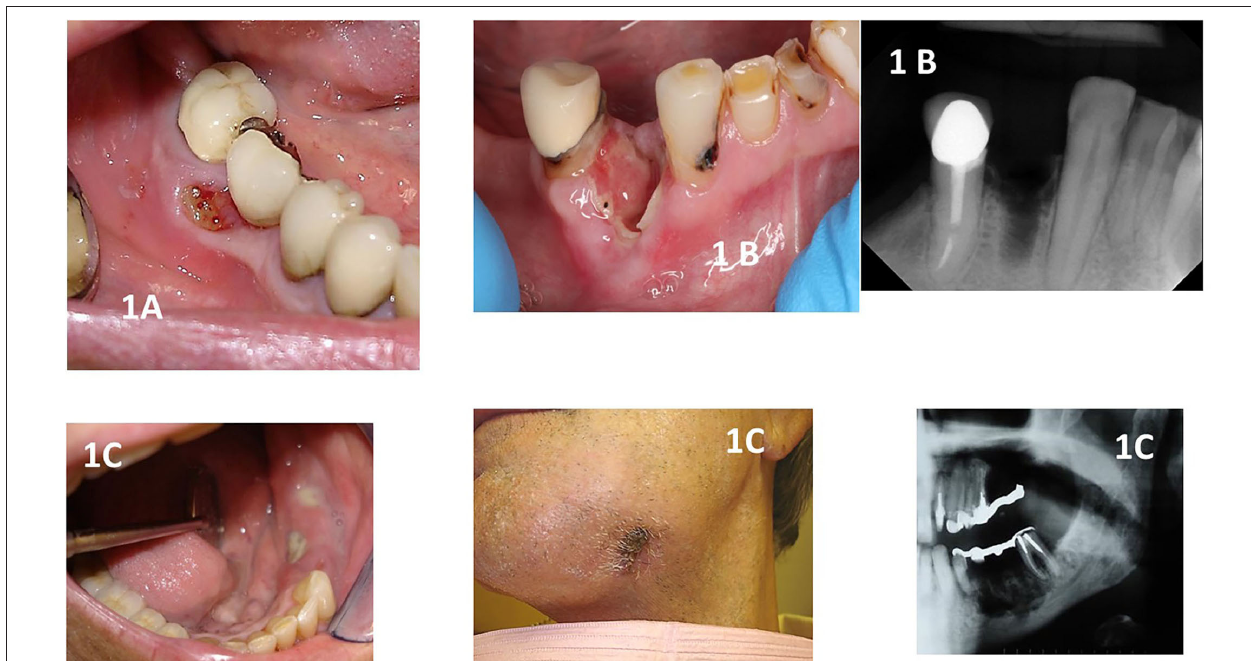
FIGURE 1 | Shows clinical and radiographical images of different stages of MRONJ. (A) : stage 1 showing a patient with breast cancer taking zoledronic acid with a small asymptomatic area of exposed necrotic bone that was affecting the use of a removable prosthodontic appliance. (B) : shows a patient taking denosumab who had a recent dental extraction. The site was not healing, and exposed alveolar bone could be seen. The patient was in pain and did not respond to antibiotics. The radiographical image shows the non-healing alveolus. (C) : shows a patient with multiple myeloma with Stage 3 MRONJ. The patient was in pain and presented to the clinic with swelling of the alveolar mucosa and several areas of infected and exposed bone with pus drainage. The patient complained of paresthesia in the area and had a strong mal odor. One can observe an extraoral fistula on the left submandibular area. The radiograph shows the extensive area of bone destruction, placing the patient at risk for a pathological fracture. Note that the fixed prosthodontic appliance was removed, revealing the exposed bone seen in this